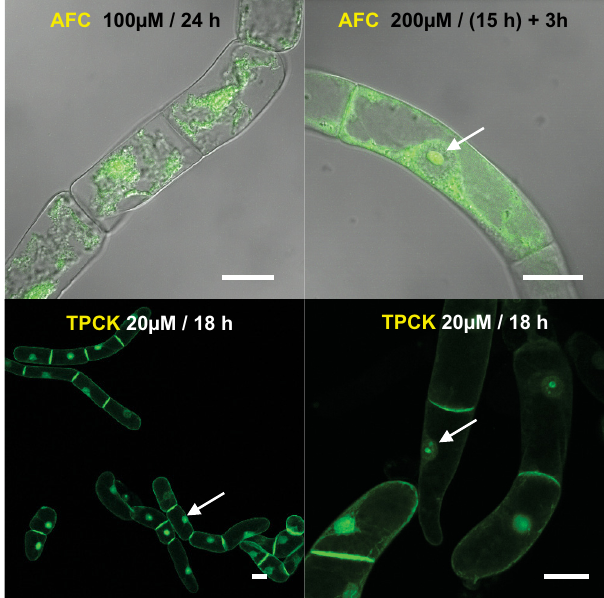
Figure 3. Effect of post-prenylation inhibitors on the localization of the geranylgeranylated fusion protein H -GFP-BD-CVIL. AFC: 6 N -acetyl- S -farnesyl- l -cysteine, an inhibitor of isoprenylcysteine carboxyl methyltransferase; TPCK: N -tosyl- l -phenylalanine chloromethyl ketone, a serine and cysteine proteinase inhibitor. White bars =